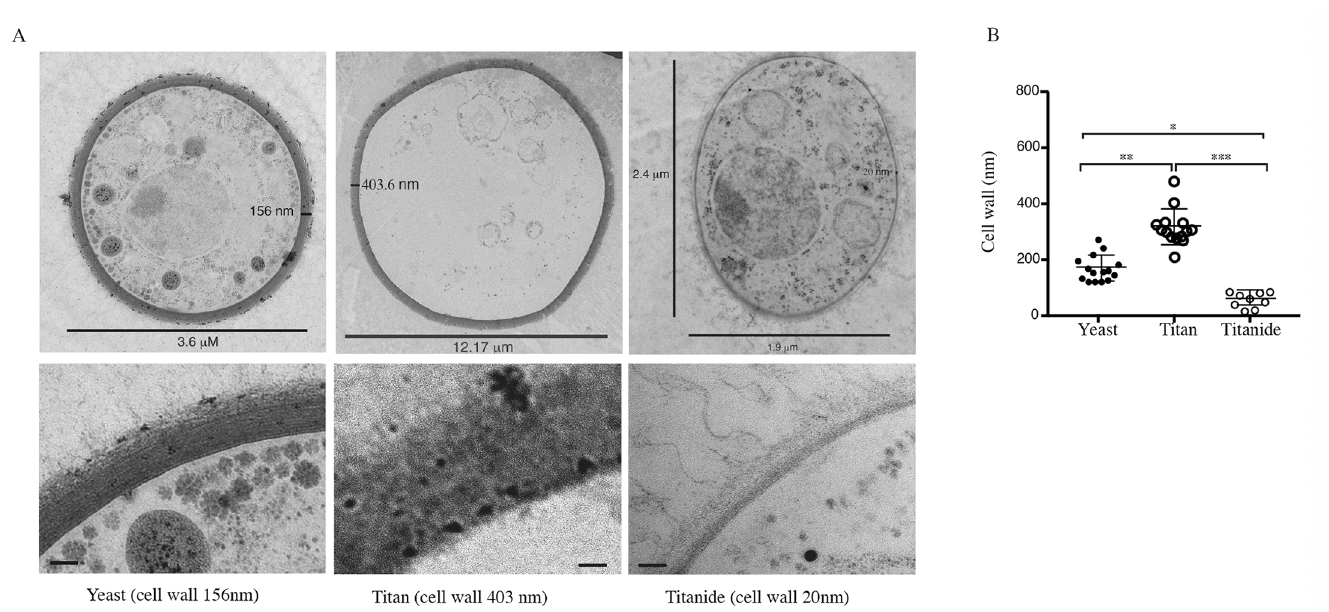
Fig 2. In vitro induced cells were analysed by TEM. Representative micrographs (A) and cell wall thickness for Yeast (n = 15), Titan (n = 14), and Titanide (n = 9) cells (B). Significance was assessed using Kruskal-Wallis and Dunn’s multiple comparisons tests ( (cid:3) p = 0.027; (cid:3)(cid:3) p = 0.002; (cid:3)(cid:3)(cid:3) p < 0.0001).